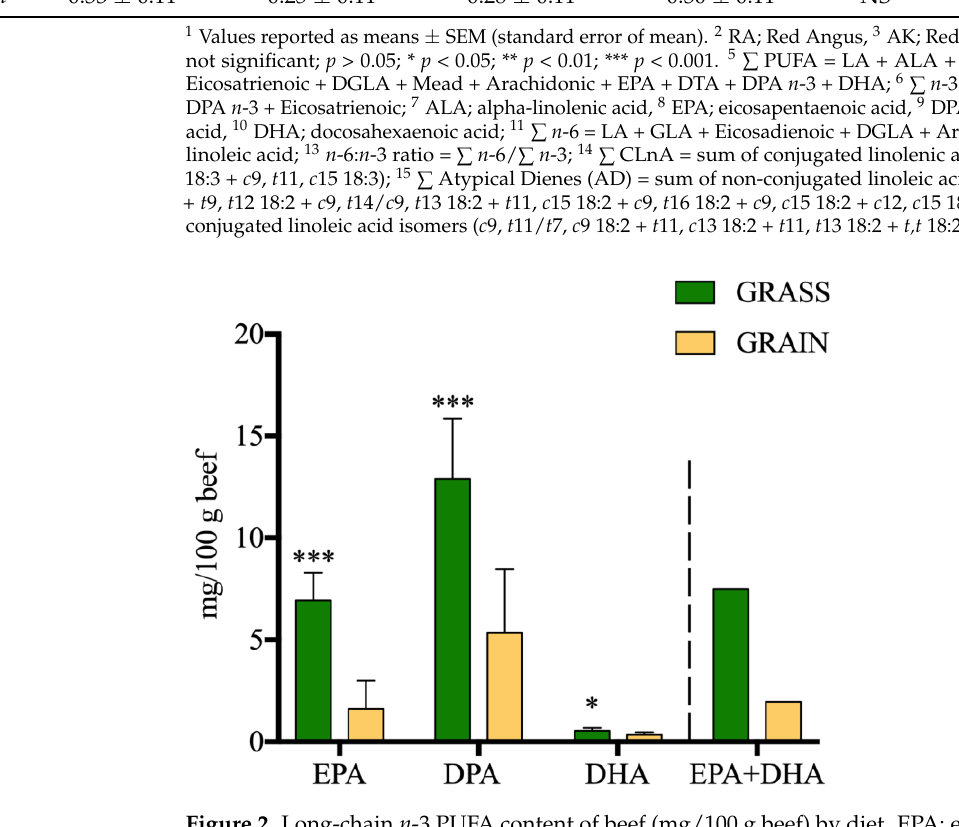
Figure 2. Long-chain n -3 PUFA content of beef (mg/100 g beef) by diet. EPA: eicosapentaenoic acid; DPA: n -3 docosapentaenoic acid; DHA: docosahexaenoic acid; EPA + DHA: sum of eicosapentaenoic acid and docosahexaenoic acid. ‘*’ denotes statistical significance (‘*’ p < 0.05, ‘***’ p < 0.001).